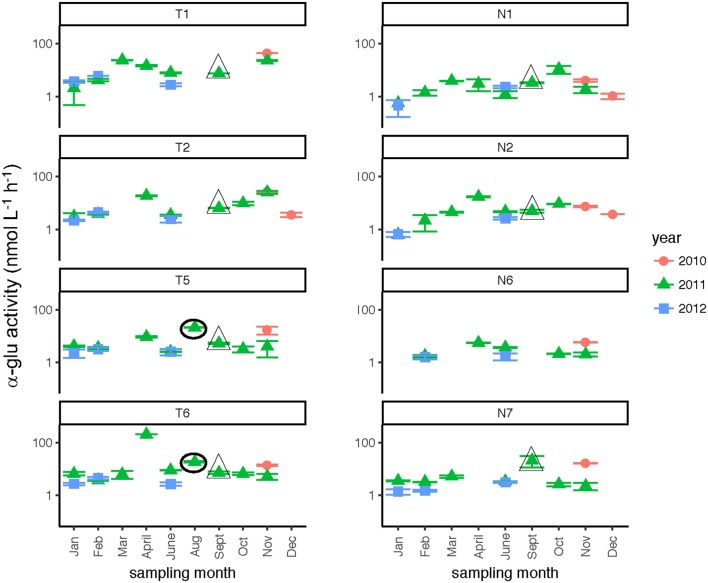
α-glucosidase activities (average and standard deviations) at four stations each in the Neuse and Tar-Pamlico Rivers from 2010 to 2012. “T” corresponds to Tar-Pamlico stations, “N” corresponds to Neuse stations. Symbols outlined with triangles show sampling carried out in the month post Hurricane Irene. Circled symbols (Stns. T5 and T6 only) show samples collected in August 2011, shortly after Hurricane Irene crossed through eastern North Carolina. y-axis is a logarithmic scale.